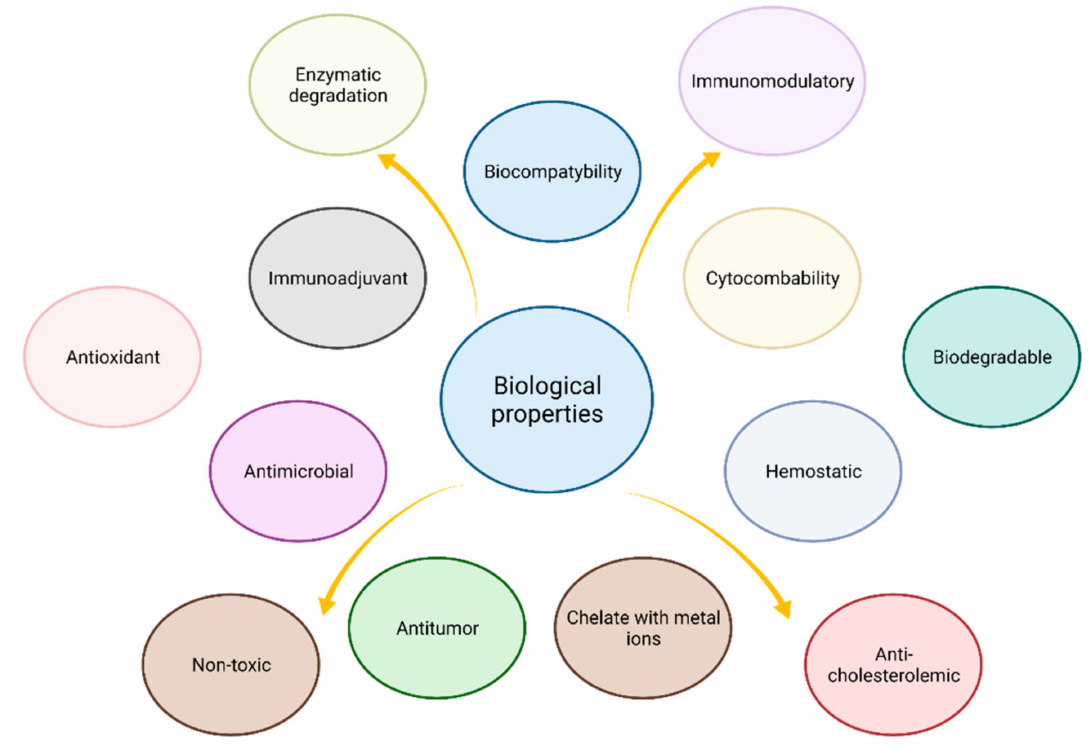
Figure 2. Biological properties of